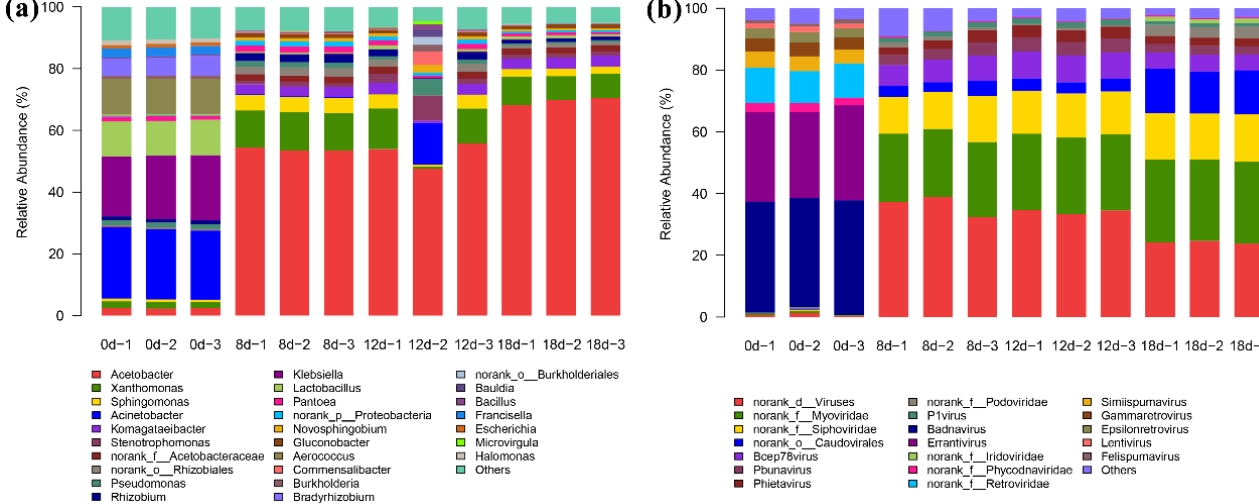
Figure 2. Bacterial and viral community diversities (at genus level) in vinegar Pei (( a ) bacteria, ( b ) virus).